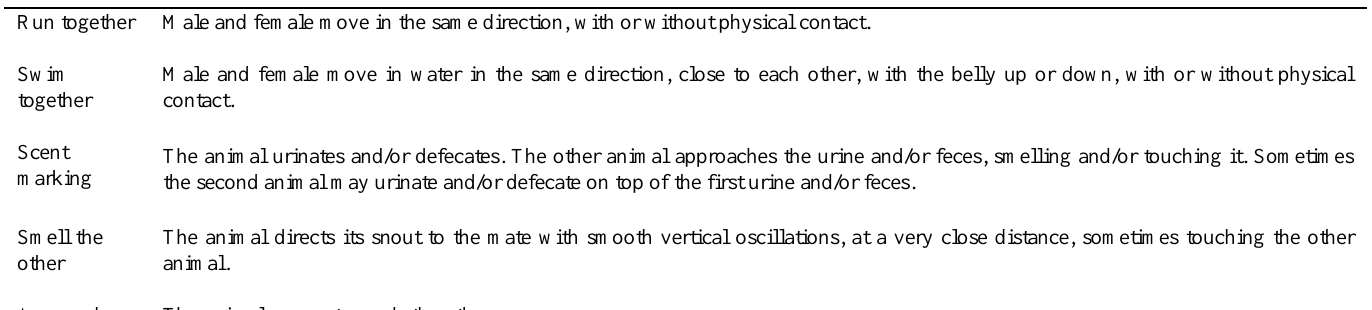
Table 2 Ethogram of the Common Otter in Captivity for the Interaction Category of Behaviors